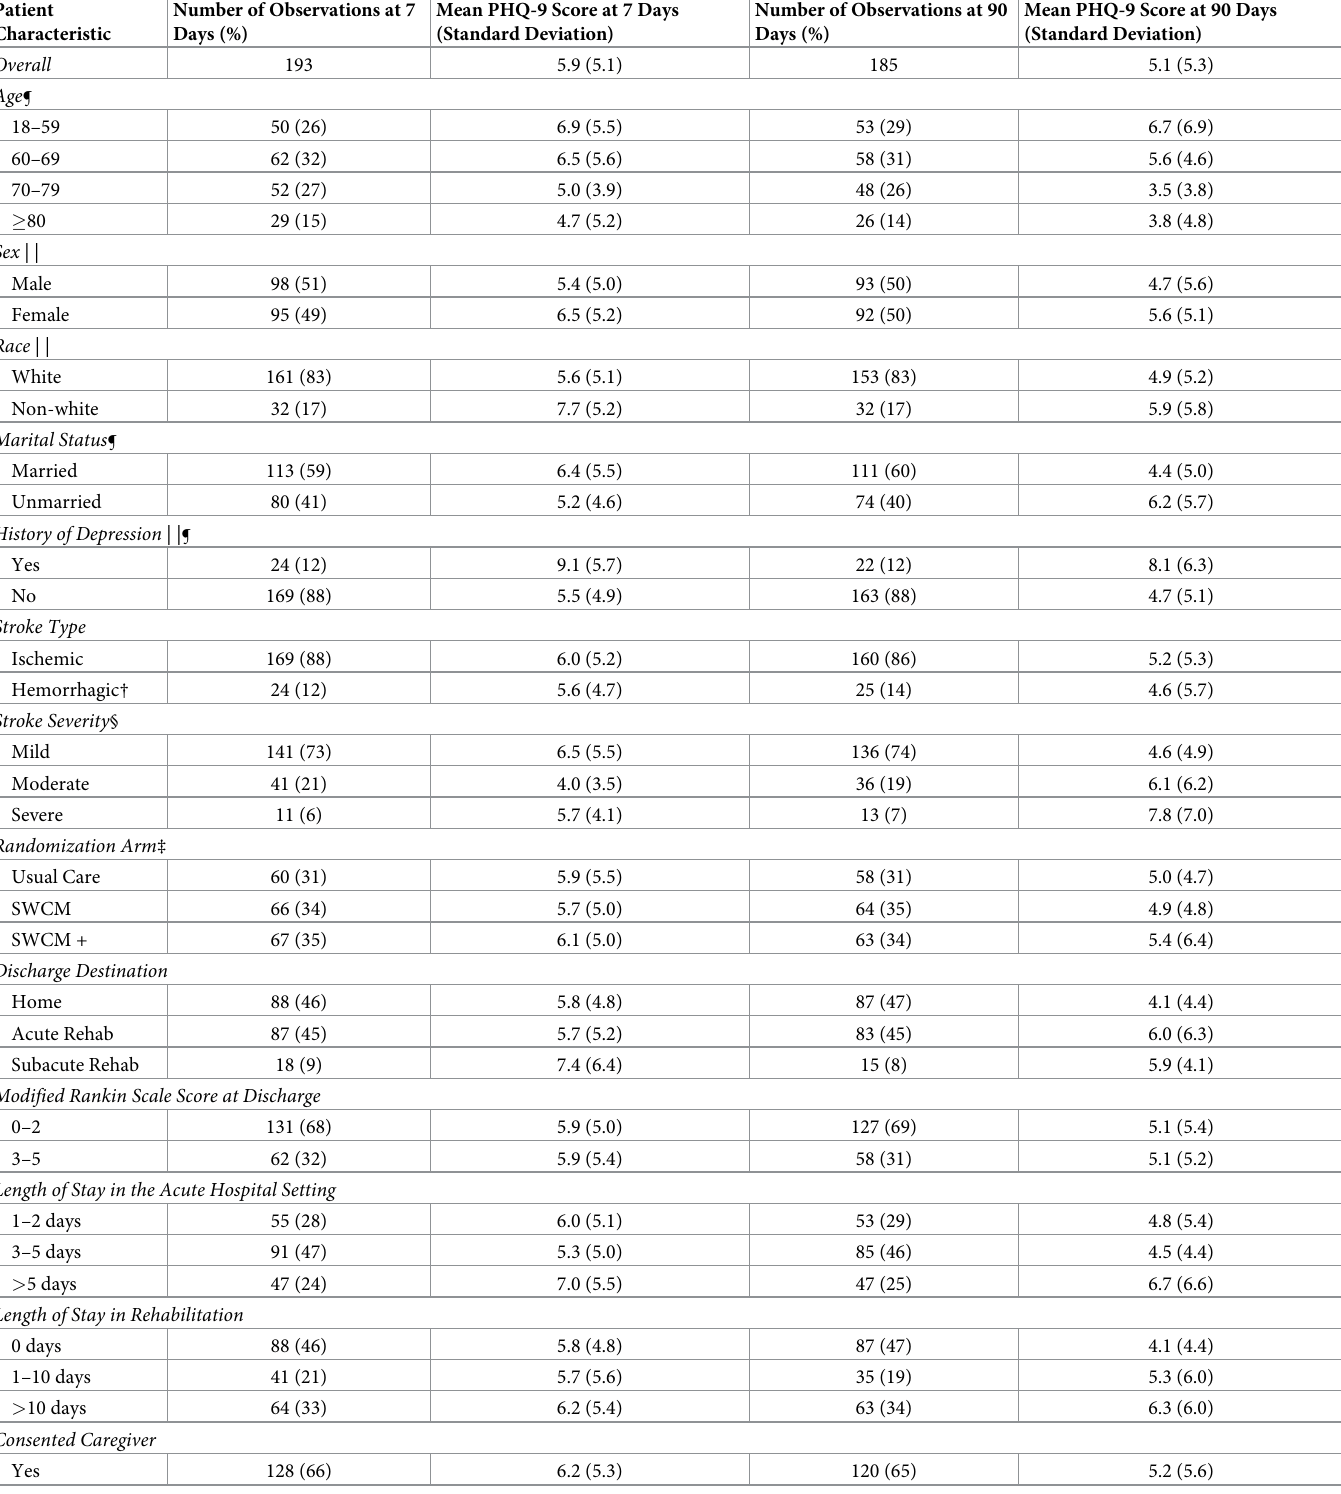
Table 1. Unadjusted mean PHQ-9 score at 7 and 90 days by patient characteristics (n = 214 patients �